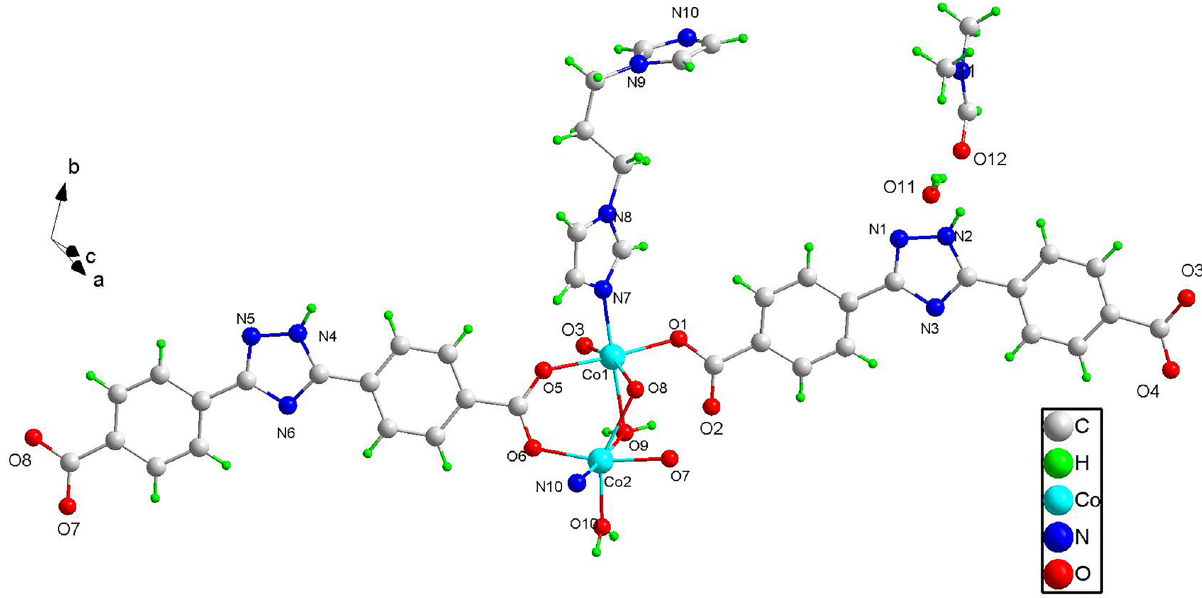
Table 1 contains crystallographic data and Table 2 contains the list of the atoms including atomic coordinates and displacement parameters.